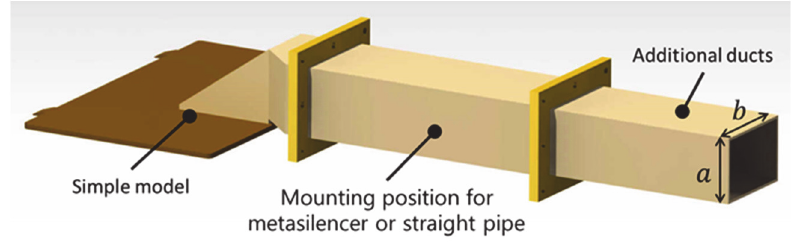
Figure 3. 3D model with straight pipe in simple model.